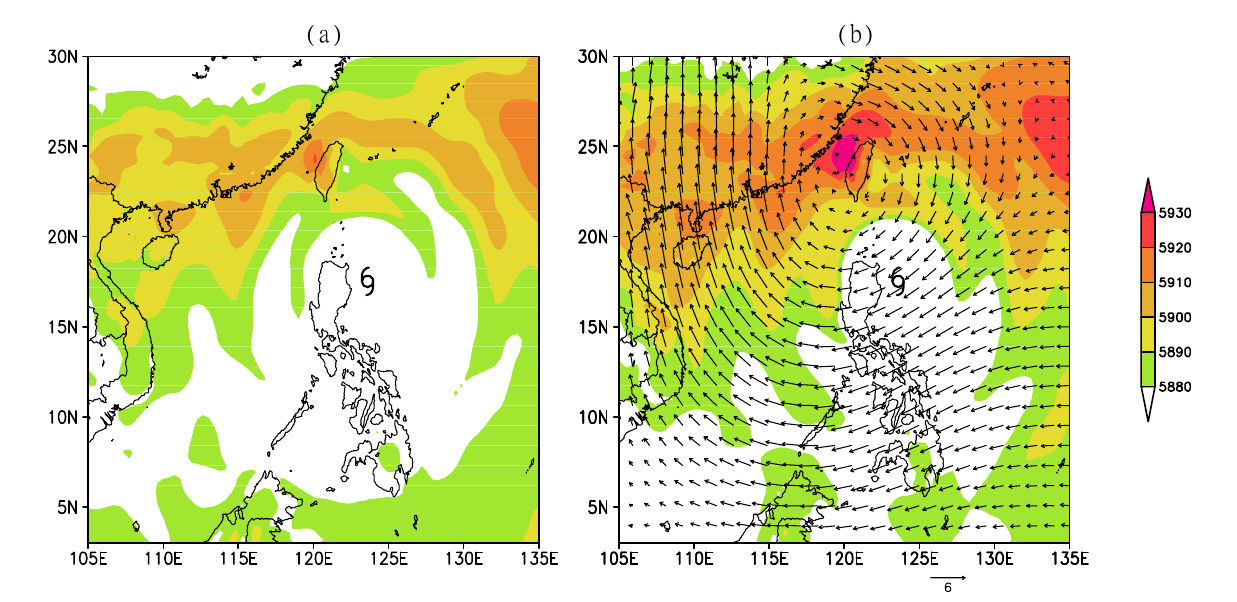
Figure 6. Initial geopotential heights (shaded, unit: gpm) at 500 hPa for the ( a ) CTL and ( b ) RAD-DA experiments, superimposed by the mean wind increments (RAD-DA minus CTL, arrows, unit: m/s) at 500–700 hPa.